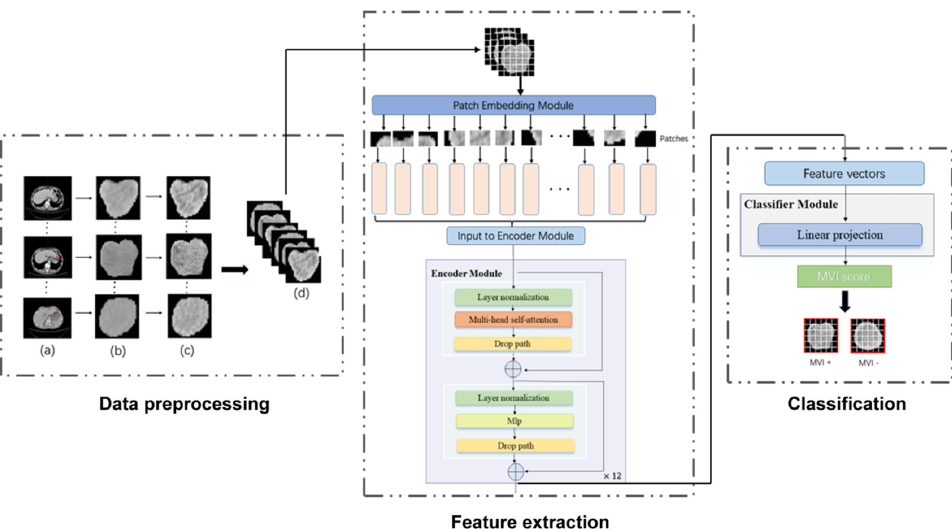
Figure 2. The workflow of our MVI − TR model. The entire process was divided into three parts: data preprocessing, feature extraction, and final classification. As for the data preprocessing, the region of tumor was drawn in the origin CT, as shown in (a). (b) were the cropped images that were resized into 224 × 224. (c) were the result after histogram equalization. Then (d) showed data augmentation, such as random rotation and horizontal flip. During feature extraction, a ROI was fed into the patch embedding module and then encoded in a feature vector of 768D through 12 encoder blocks. The MVI status was predicted by a linear projection on this 768D feature vector.